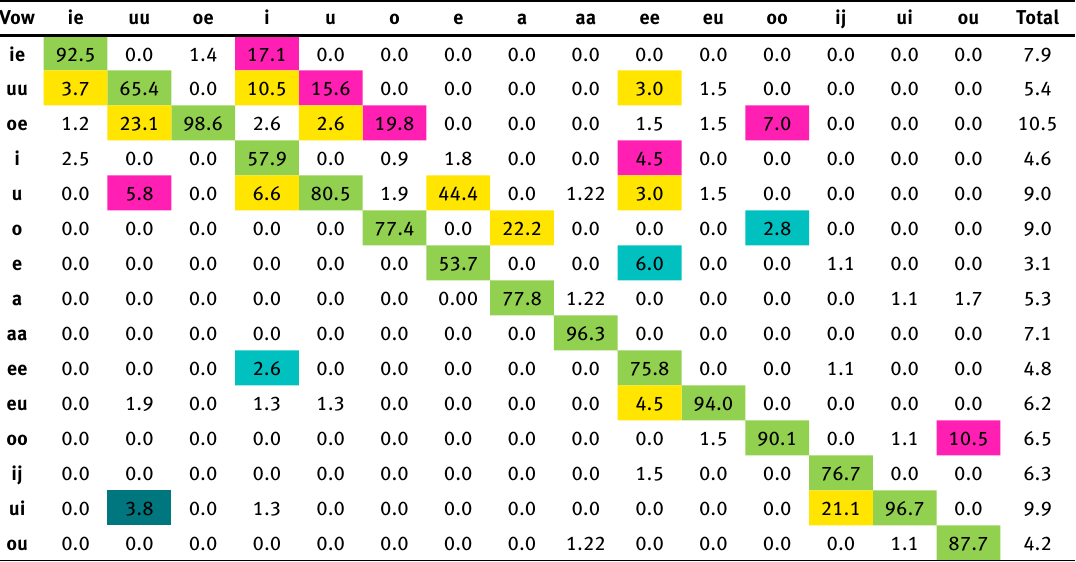
Table 10. Most frequent canonical (indicated in green) and non-canonical transcriptions of all 15 Dutch vowels produced by native Dutch speakers, as given by non-expert native Dutch listeners; target vowels in the columns, classified vowels in the rows, non-canonical transcriptions with deviations > 2.5% related to vowel height (in pink), vowel length (in turquoise), round- ing (in yellow) and diphthongization (in teal) are also indicated; Vow = target